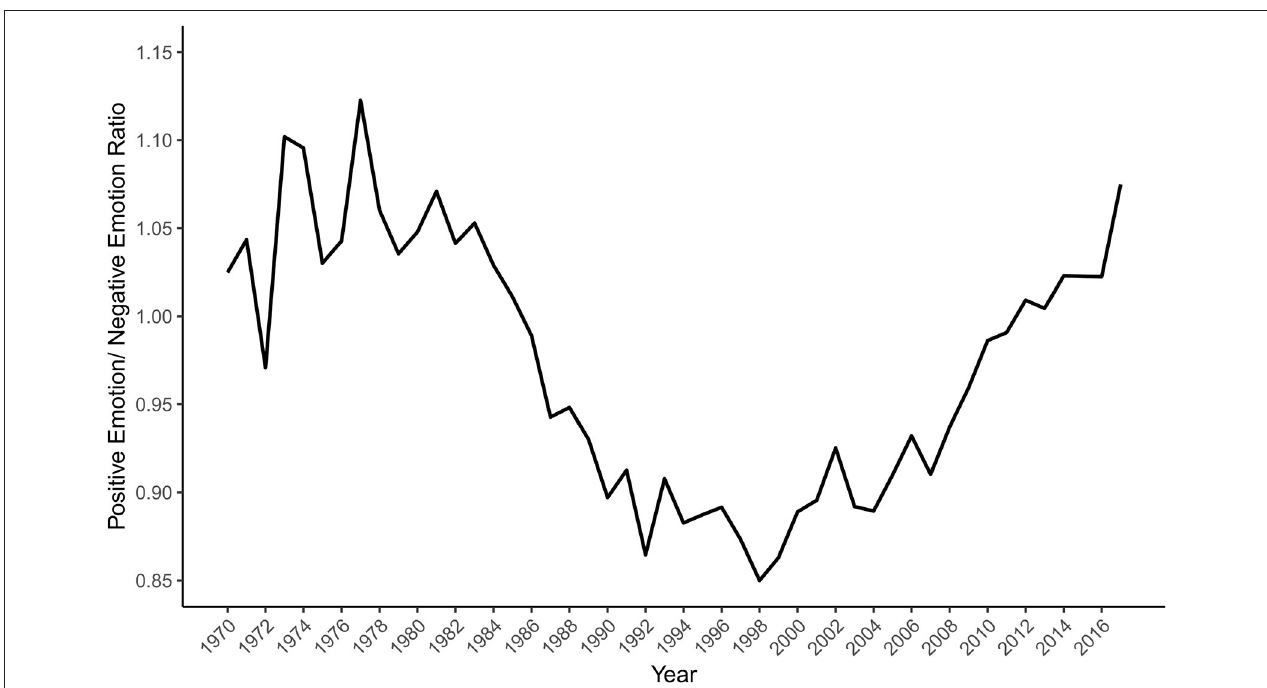
FIGURE 3 | Ratio of the positive emotion and negative emotion indices by